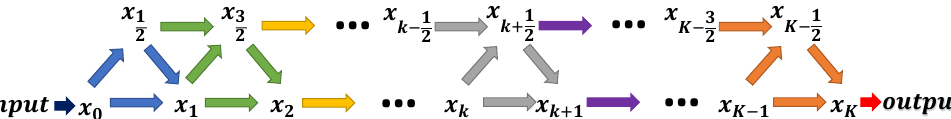
Figure 1. Overview of the K -phase extra proximal gradient network (EPGN) architecture. The arrows in the same color indicate computations within the same phase and share the same operators and